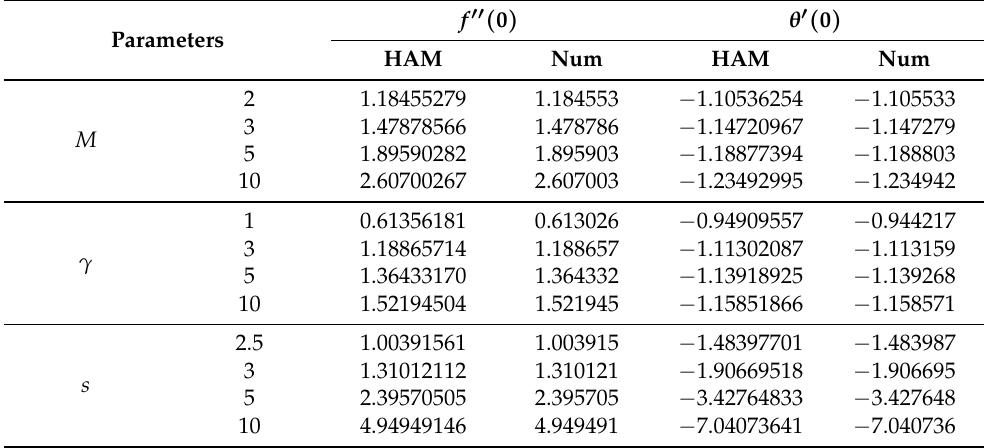
Figure 4. Total average residual error of Equations (8) and (9) in cases of γ = 1 and γ = 5 for M = 3, s = 2, Pr = 0.71 at different orders of approximation given by HAM using non-optimal c f = − 0.504 (for γ = 1), optimal c f c θ 0 = − 0.427 (for γ = 5), respectively. c θ ∗ 0 Table 1. Analytic approximations (HAM) of f (cid:48)(cid:48) ( 0 ) , θ (cid:48) ( 0 ) compared with numerical results for various M , γ and s in case of Pr =